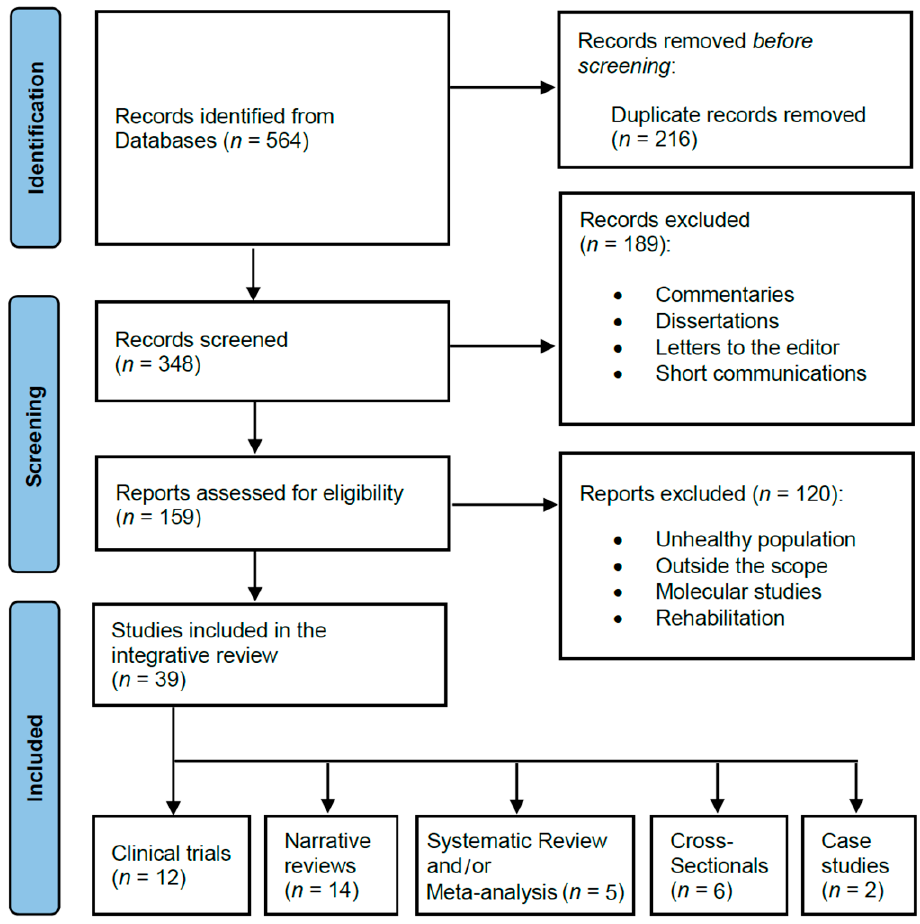
Figure 1. PRISMA flow diagram.